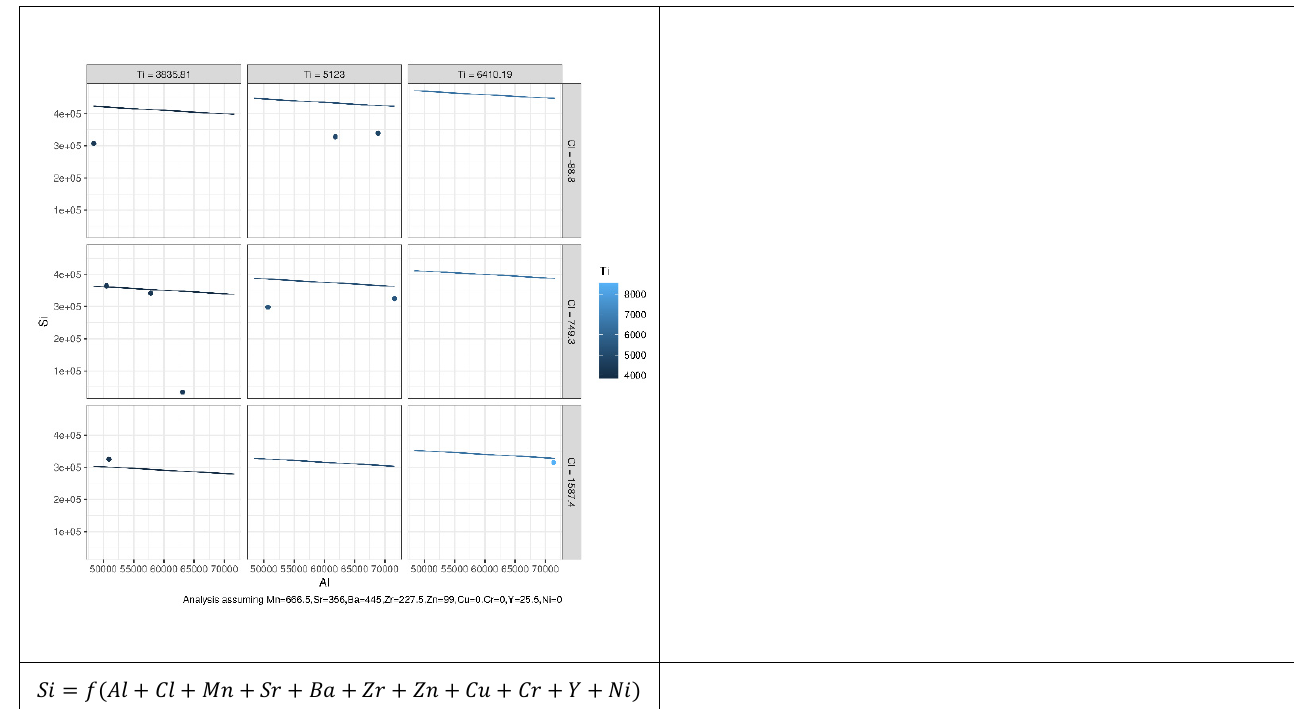
Figure 8. Prediction error of 196 MLR models constructed to reveal the relation between Si as an independent element and other elements based on the permutation approach. Each model describes possible relationships between the dependent variables and other explanatory variables that led to the best results.